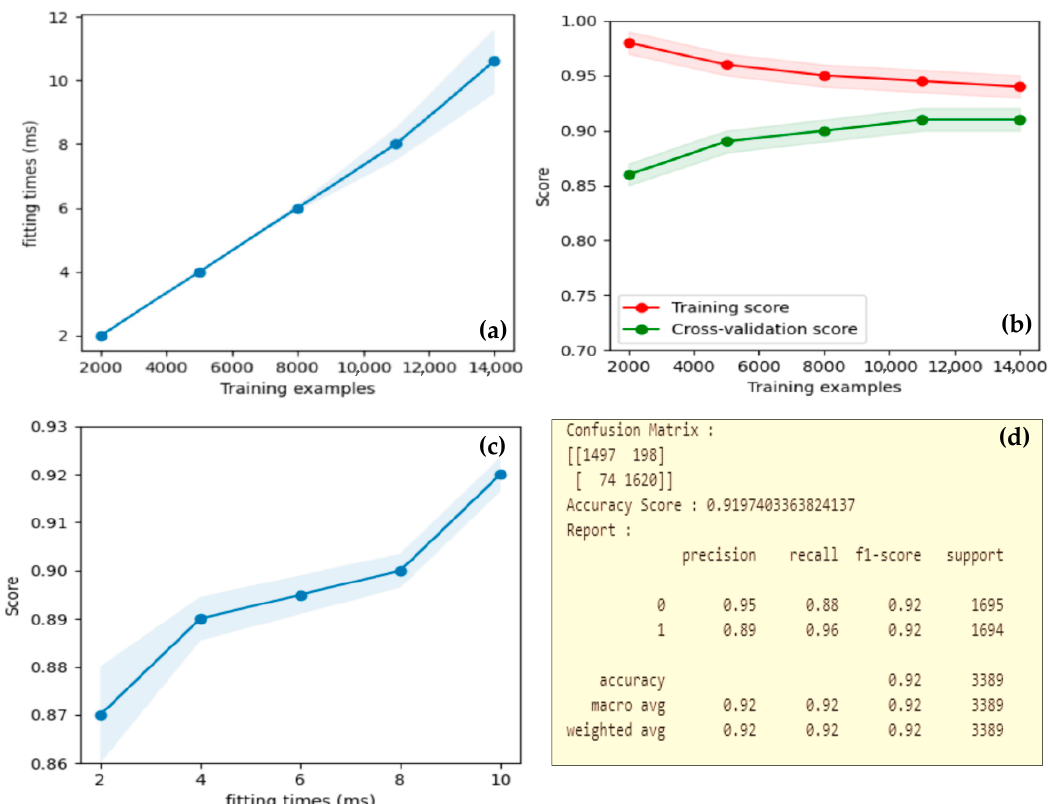
Figure 11. Combined dataset model (Random Forest)—Scalability ( a ), Learning Curve ( b ) on Training examples, Perfor- mance Curve, ( c ) and Evaluation metrics ( d ).